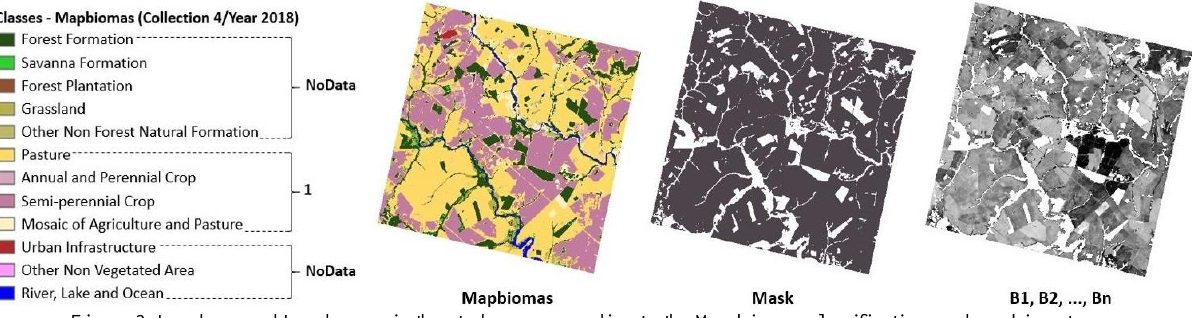
Figure 3. Land use and Land cover in the study area according to the Mapbiomas classification, and masking stages.